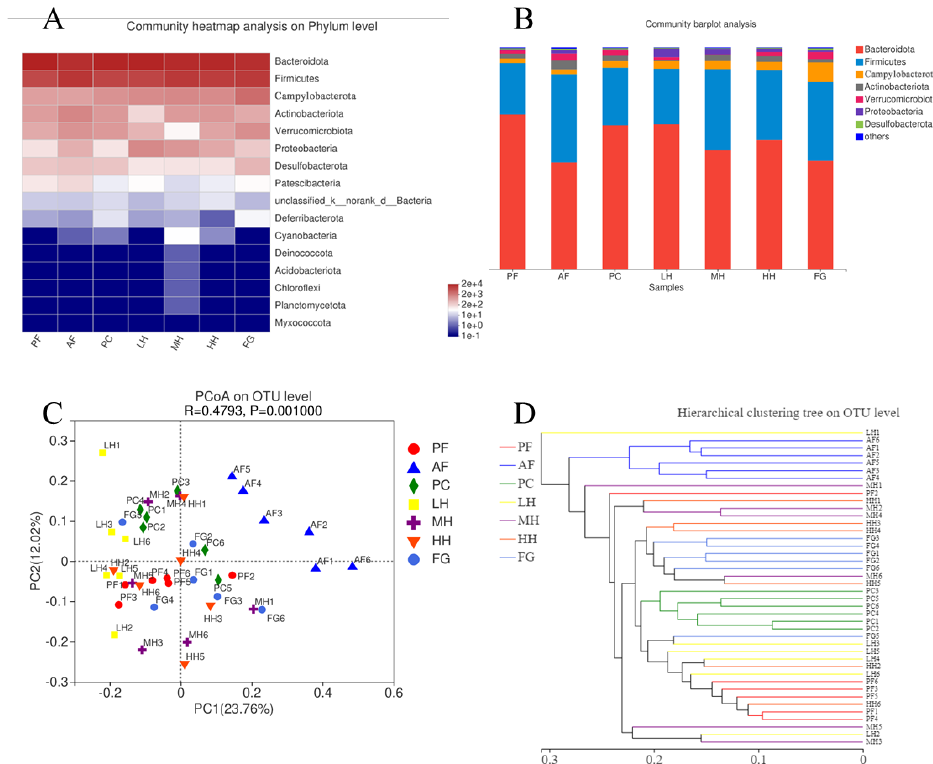
Figure 2. Citrus honey alters the gut microbiota structure in mice. Structures of gut microbiota of mice were analyzed using 16S rRNA gene sequencing and bioinformatics analysis. ( A ) Relative analysis of the community heatmap at the phylum level. ( B ) Composition and relative abundances of the gut microbiota at the phylum level. ( C ) Unweighted uniFrac–based principal coordinates analysis (PCoA) plots. ( D ) Operational taxonomic units (OTU) level hierarchical clustering tree. Note: PF represents the pair–fed control group. AF represents the alcohol–fed model group. PC represents the positive control group. LH represents the low–dose citrus honey group. MH represents the medium–dose citrus honey group. HH represents the high–dose citrus honey group. FG represents the fructose syrup group.